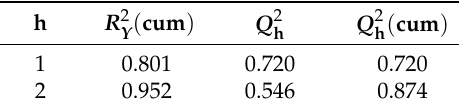
Figure 10. Construction quality of M 6400 .